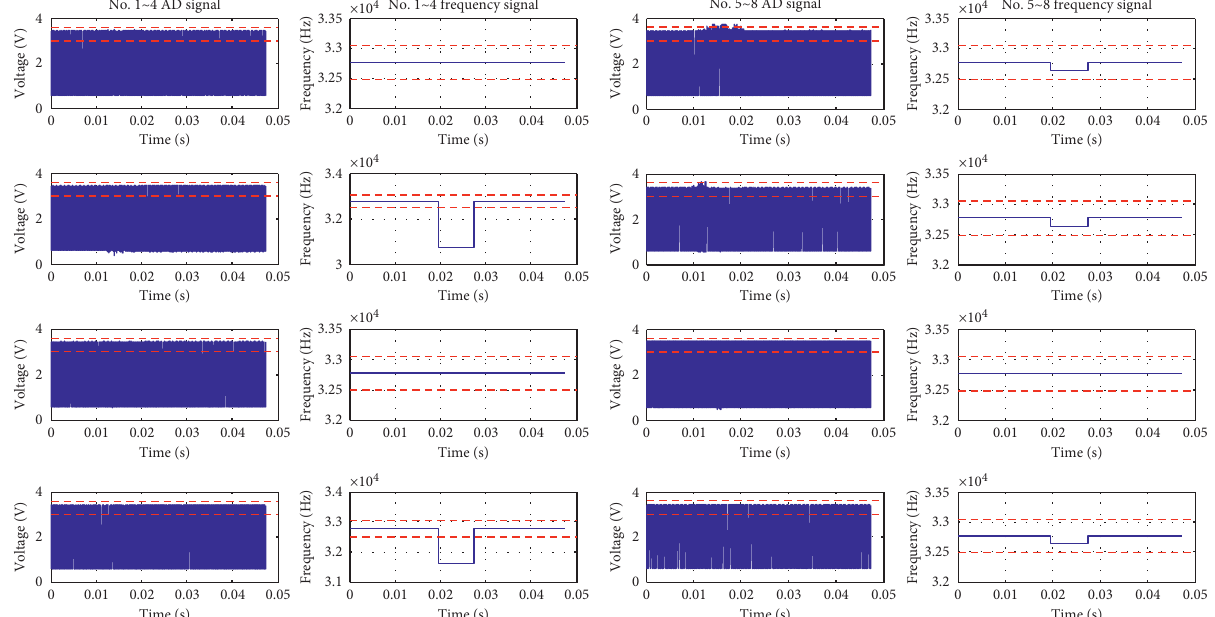
Figure 12: Electrical performance of the crystal oscillators on test board C1.